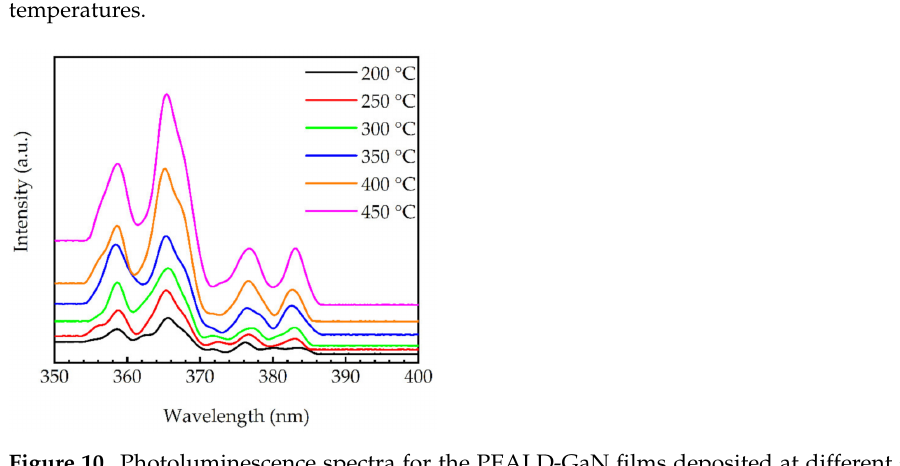
Figure 10. Photoluminescence spectra for the PEALD-GaN films deposited at different substrate temperatures. The spectra have been vertically shifted for